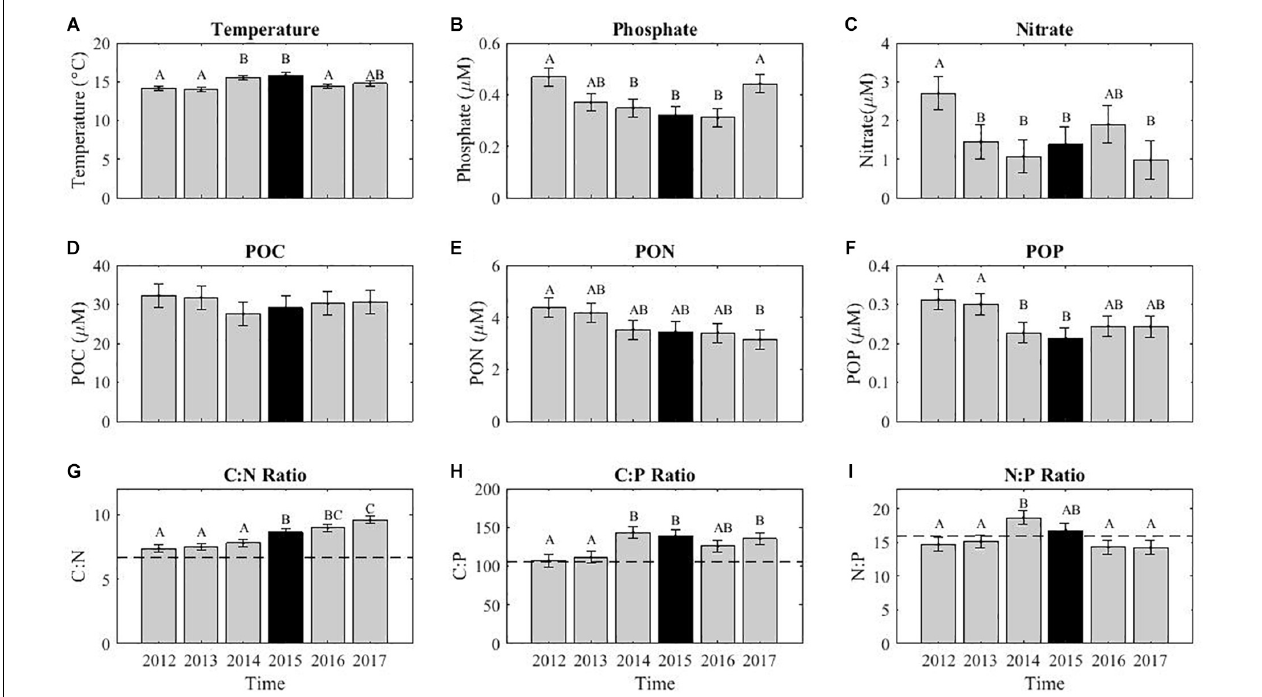
FIGURE 5 | The average annual variability in environmental conditions (A–C) , POM concentrations (D–F) , and stoichiometric ratios (G–I) . The annual variations in August quantified using a linear decomposition of annual and monthly variation. Error bars represent the standard deviation. The letters above each bar represent a post hoc Tukey multiple comparison test ( p < 0.05), where similar letters show no statistical difference. The dashed lines across the stoichiometric ratios indicates the static Redfield ratio (C: N = 6.6, C: P = 106, and N: P = 16), strictly used for comparison